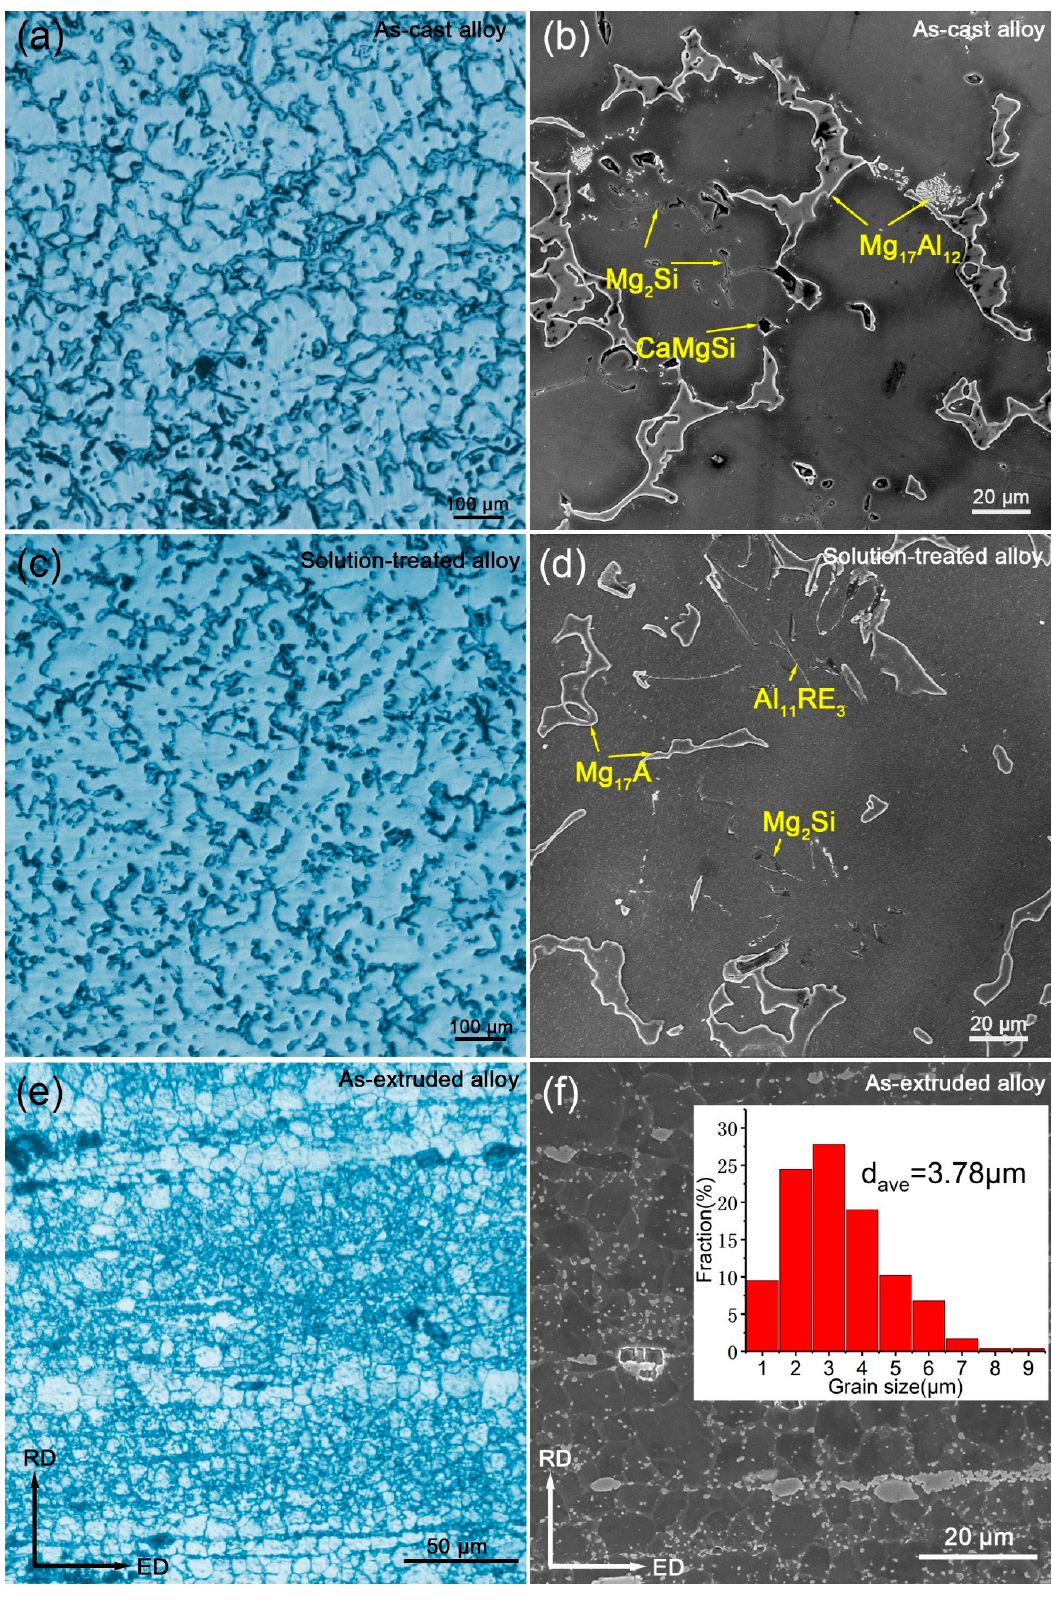
Figure 3. The OM and SEM images of the as-cast, solution-treated and as-extruded AZXSE91000: ( a ), ( b ) as-cast sample; ( c ), ( d ) solution-treated sample; ( e ), ( f ) as-extruded sample (ED represents extrusion direction; RD represents radial direction).